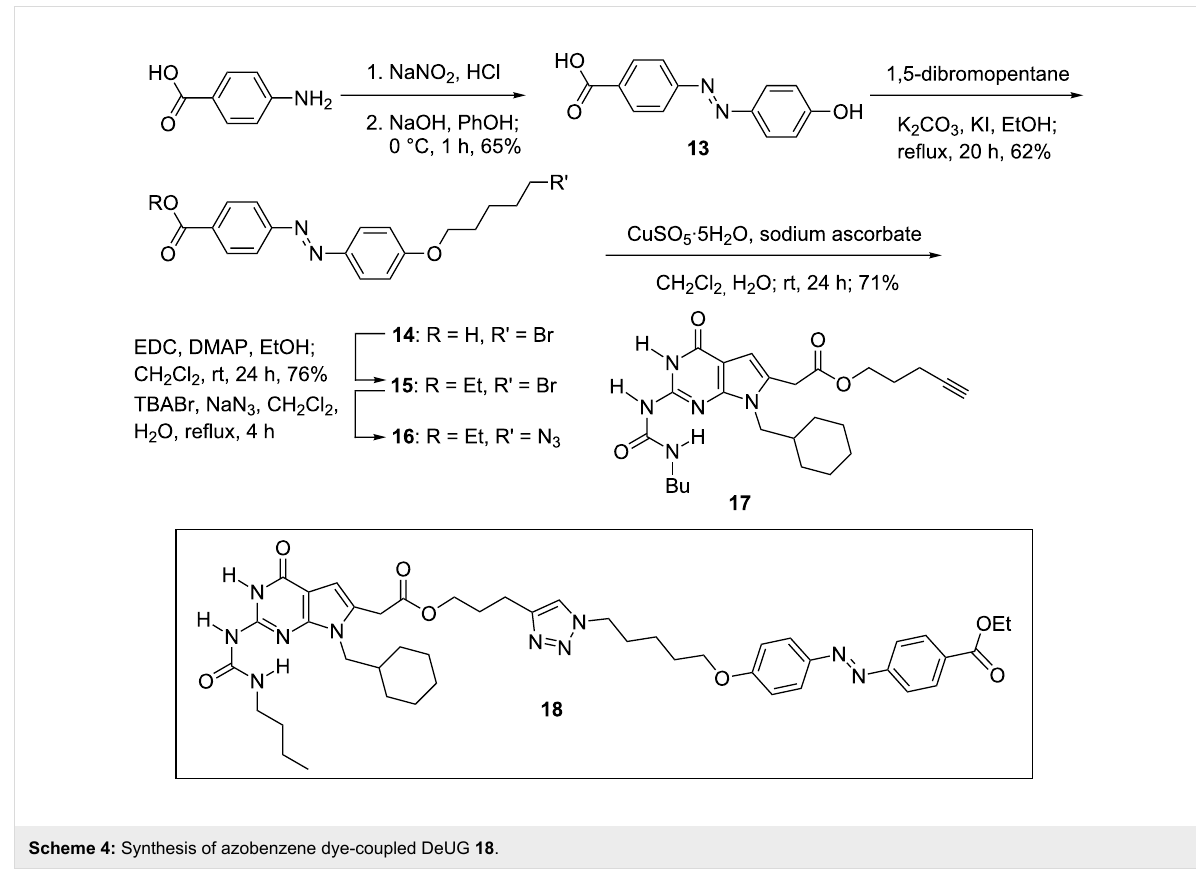
Scheme 4: Synthesis of azobenzene dye-coupled DeUG 18 .